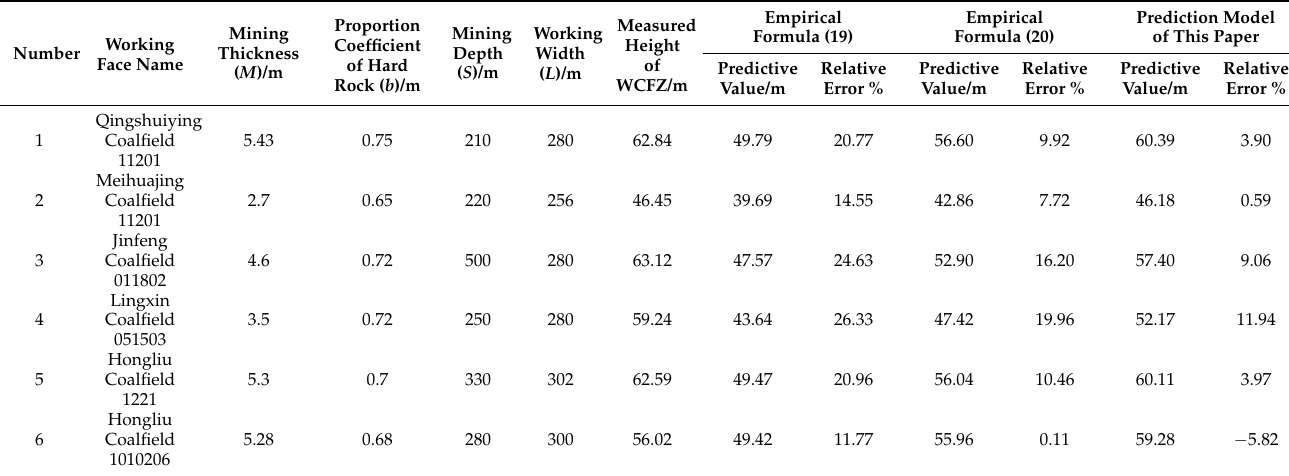
Table 5. Error analysis of each formula.